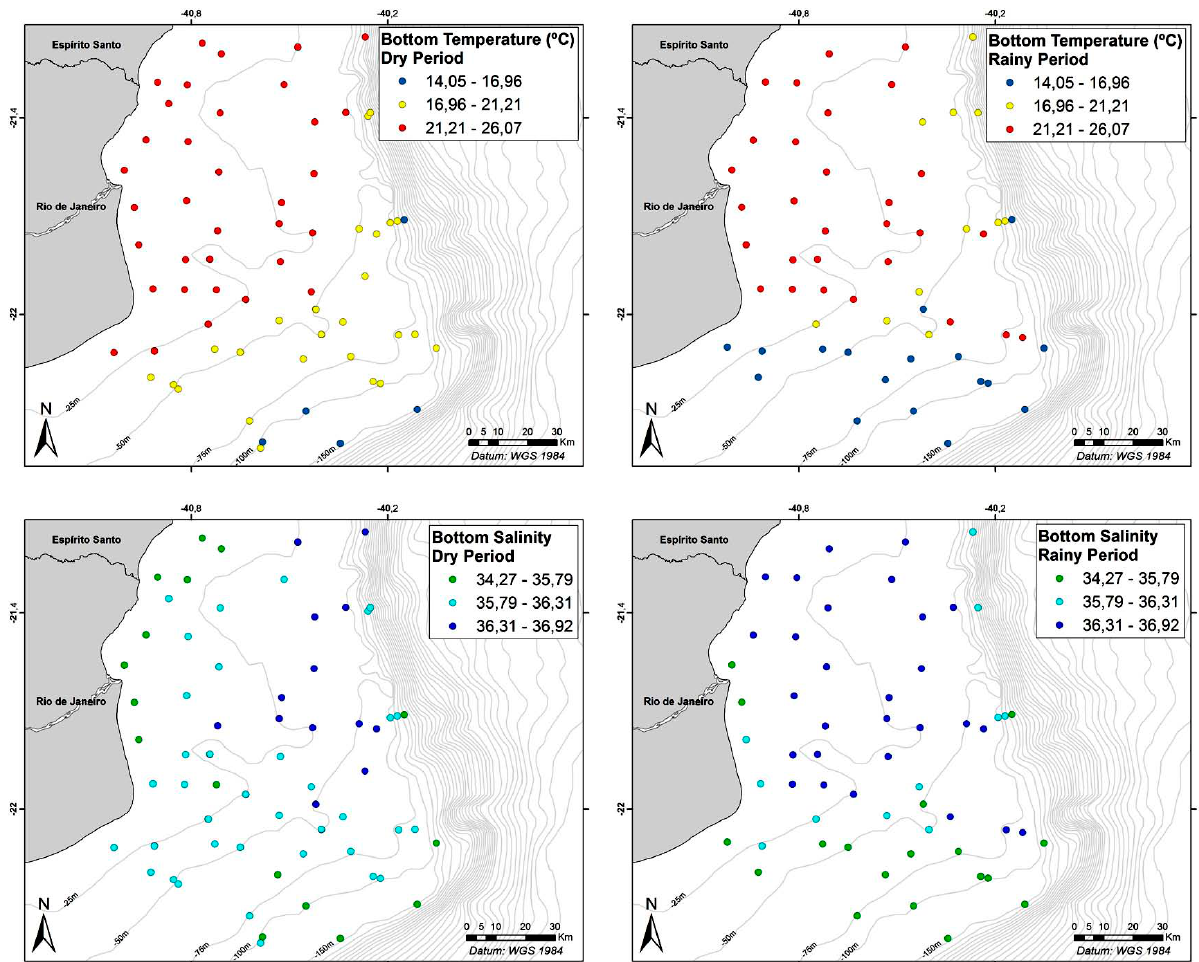
Fig. 2. – The mean temperature and salinity values at the 53 stations located along the southeast continental shelf of Brazil (A, tem- perature, dry period; B, temperature, rainy period; C, salinity, dry period; D, salinity, rainy